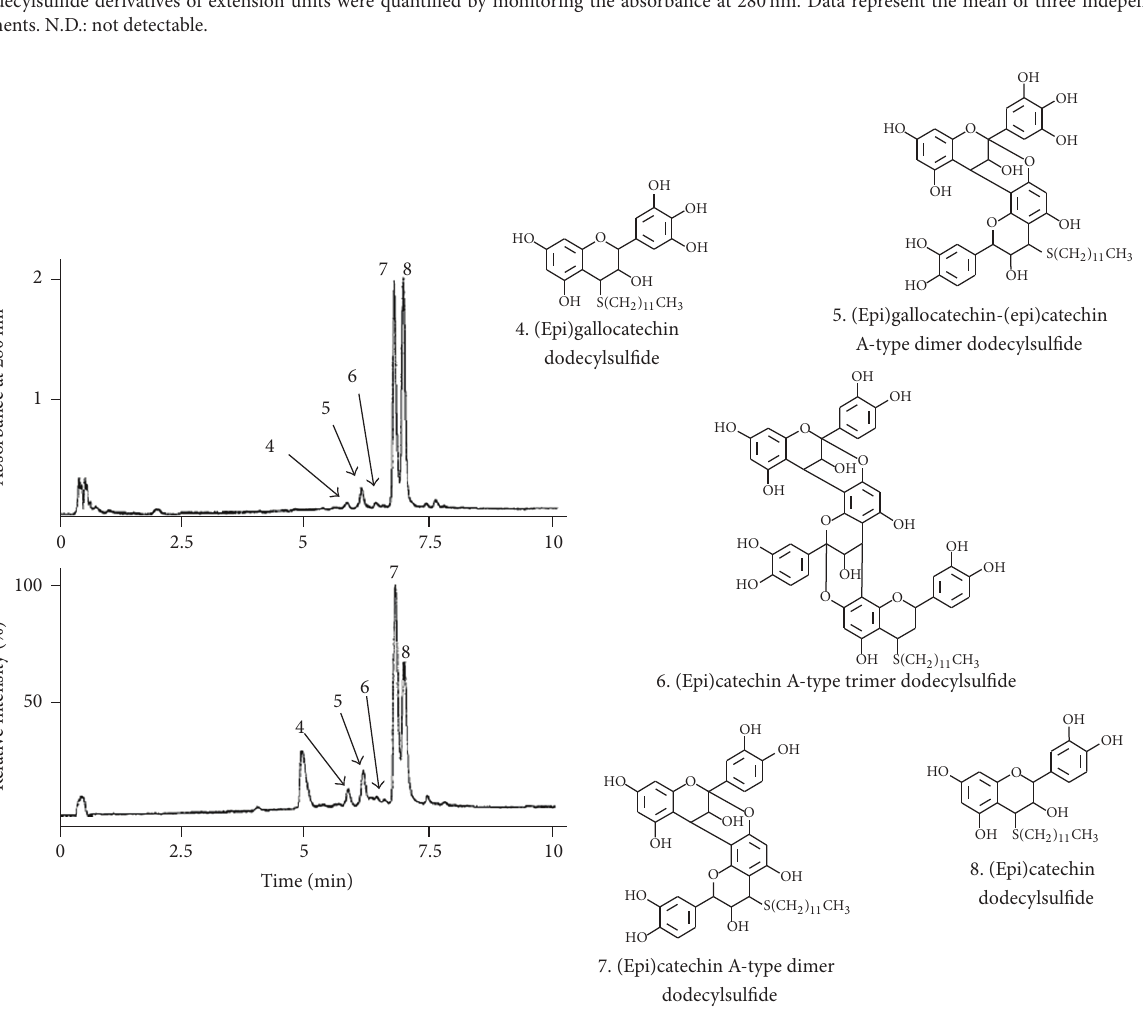
F 3: Analysis of extension units of the AF2 fraction of highly polymeric proanthocyanidins from seed shells of Japanese horse chestnut as the dodecylsul�de derivatives a�er thiolytic cleavage by